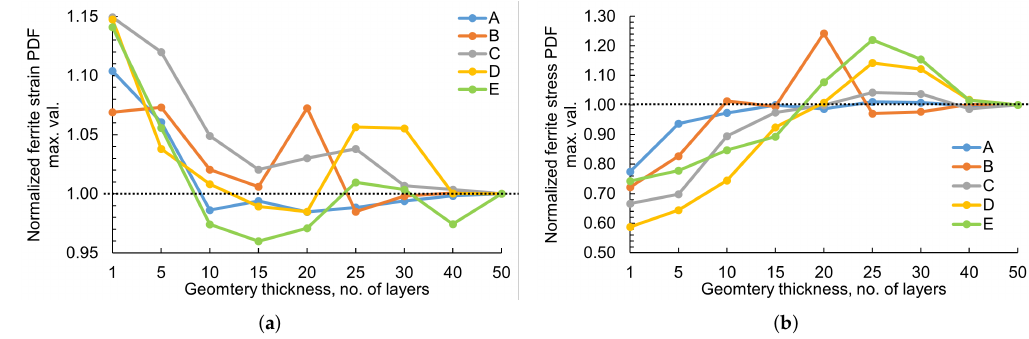
Figure 9. Peak values of PDF normalized against the 50-layer thickness simulation for ( a ) ferrite strain and ( b ) ferrite stress for D f between 8.2 µ m to 18.2 µ m at 25% of the true global strain. Dotted lines represent normalization index of 1. It is observed that for all D f , increasing the RVE thickness converges the